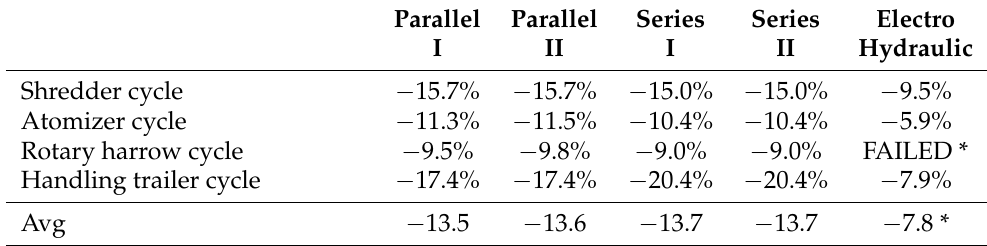
Table 8. Fuel consumption on working cycles compared to conventional